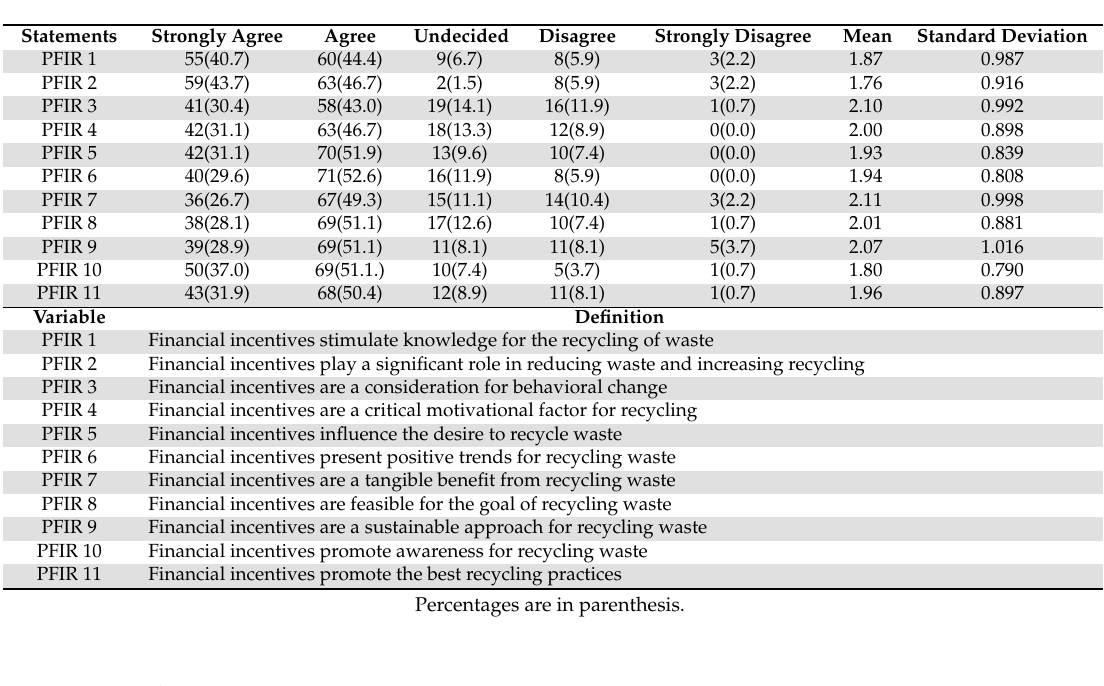
Table 1. Descriptive statistics of households’ perception of financial incentives for